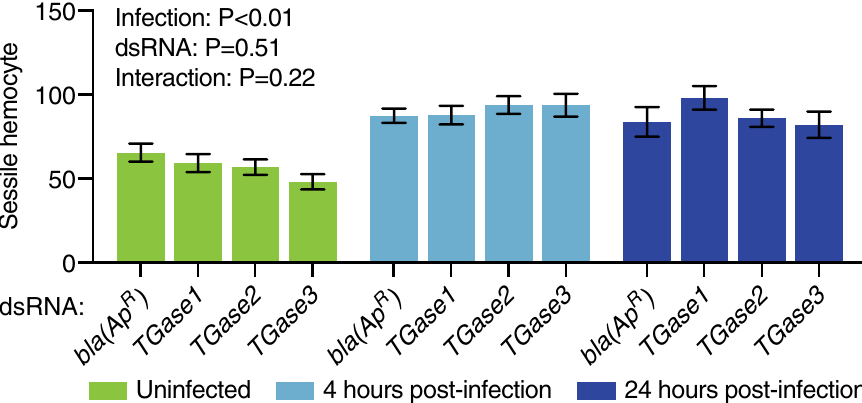
Figure 3. RNAi-based knockdown of transglutaminase genes has a limited effect on the aggregation of sessile hemocytes outside of the periostial regions. Graph shows the average number of non-periostial sessile hemocytes on the integument of dorsal abdominal segments 4 and 5 in ds bla(Ap R )- , ds TGase1- , ds TGase2- and ds TGase3- injected mosquitoes that were uninfected or had been infected with GFP- E. coli for 4 or 24 h. Data were analyzed by two-way ANOVA, using ds bla(Ap R ) mosquitoes as the reference. Column heights mark the means, and whiskers show the S.E.M.